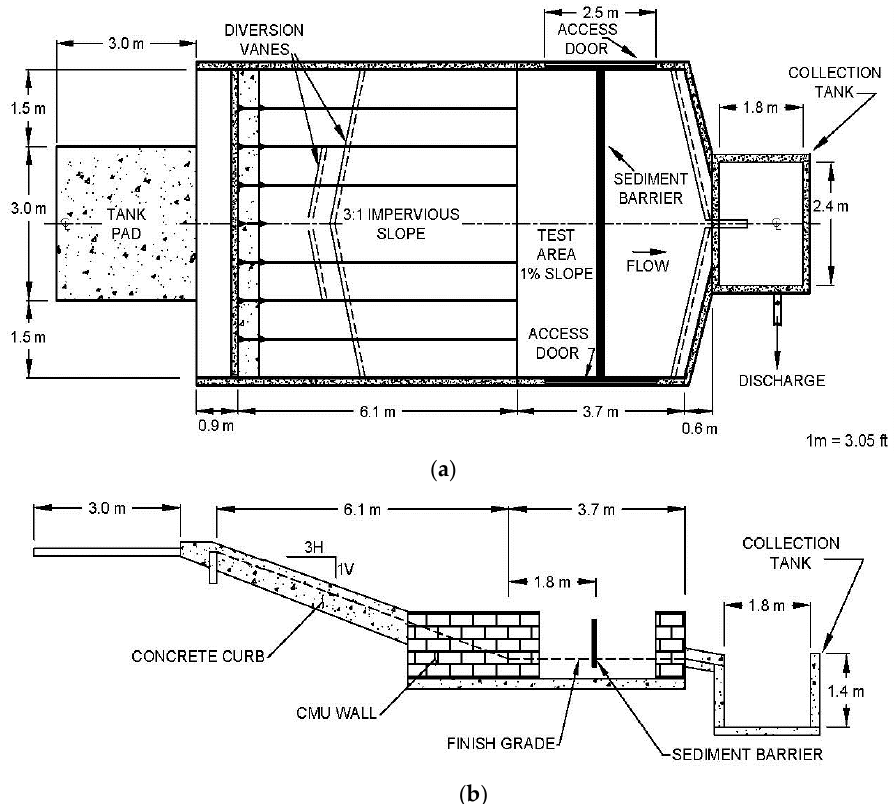
Figure 1. Plan and profile views of the test apparatus [7], ( a ) plan view, ( b ) profile view.